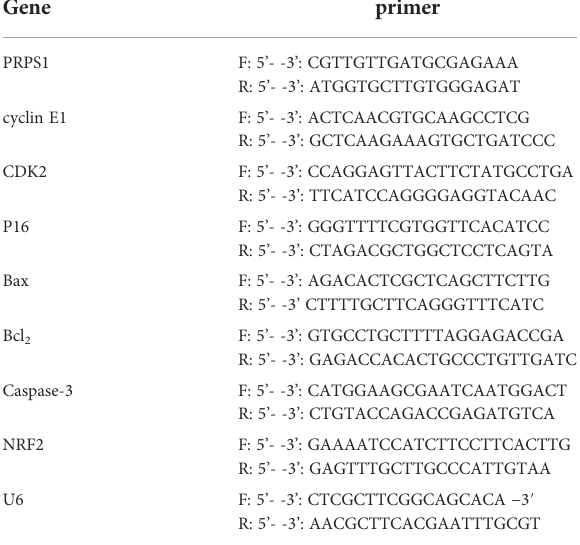
TABLE 1 the sequence of the primers for qPCR. Gene